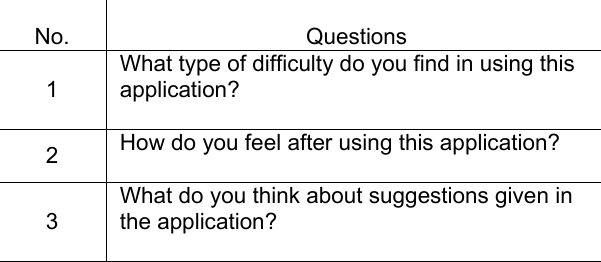
Table 5. Qualitative